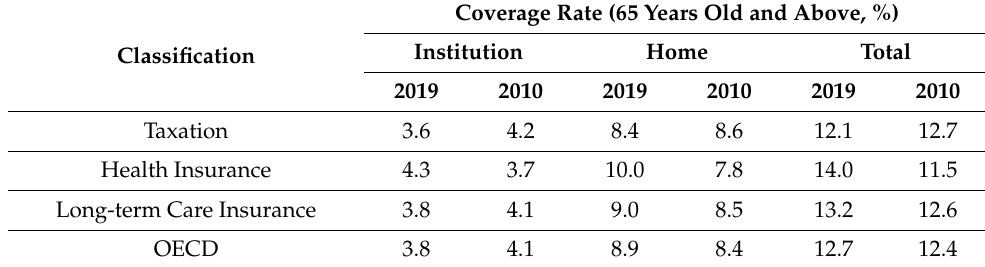
Table 4. Long-term care systems’ coverage rate according to OECD country (65 years old and above) (2010 and